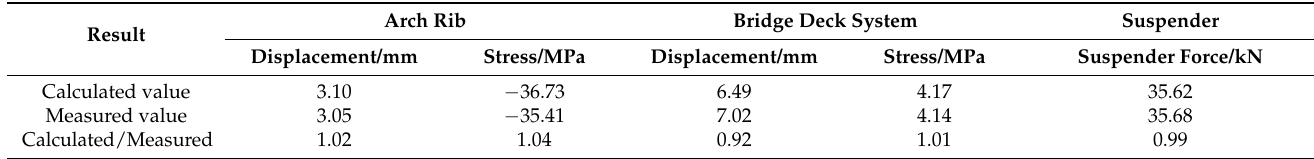
Table 1. Comparison of test and FEM results due to the 1# suspender being broken (unit: mm).